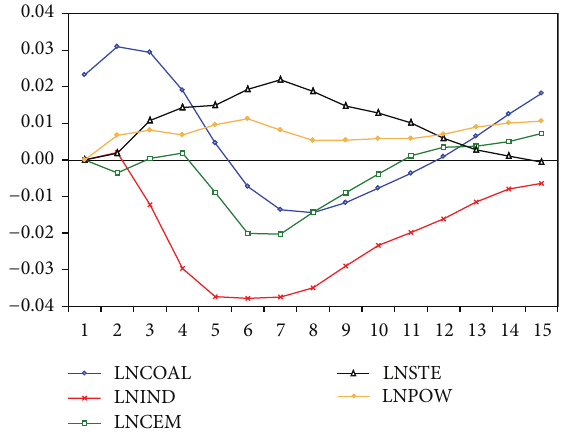
Figure 3: Factors variance decomposition on the effect of